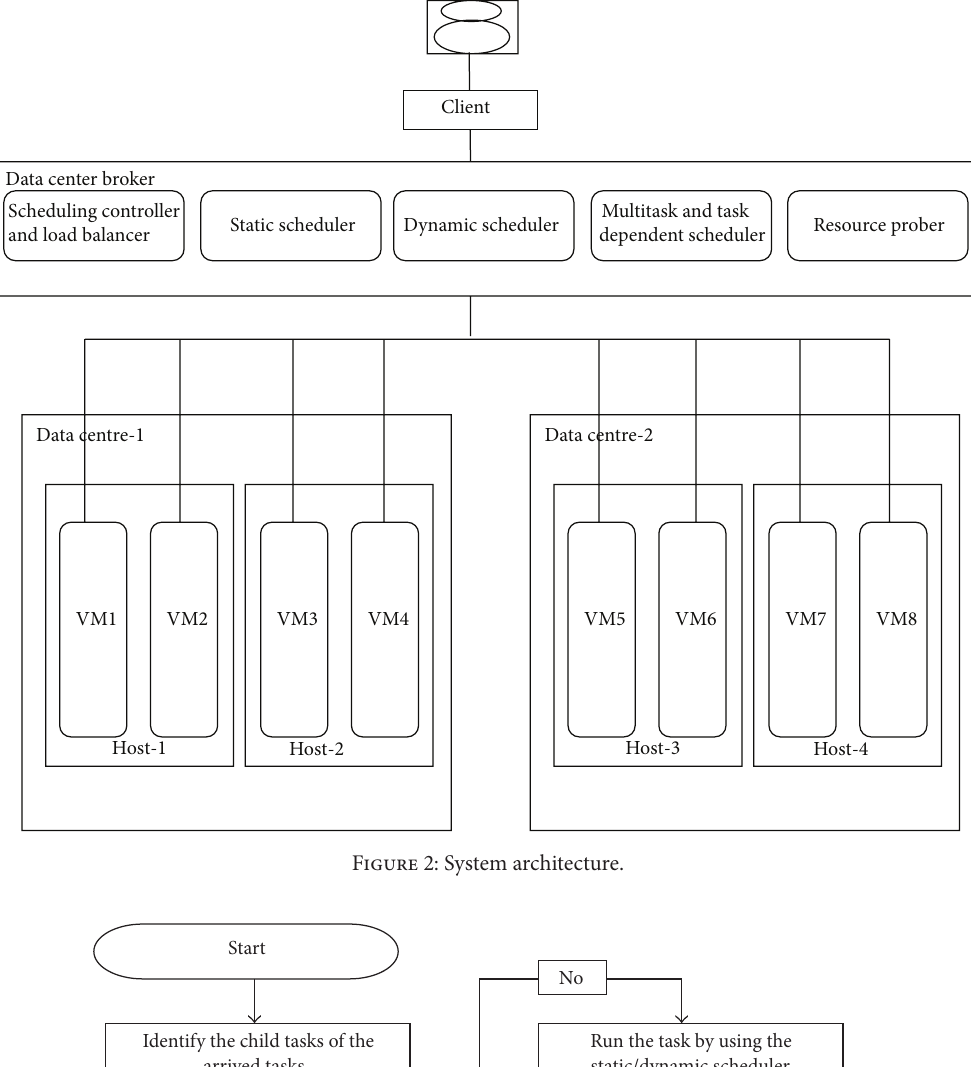
Figure 2: System architecture.